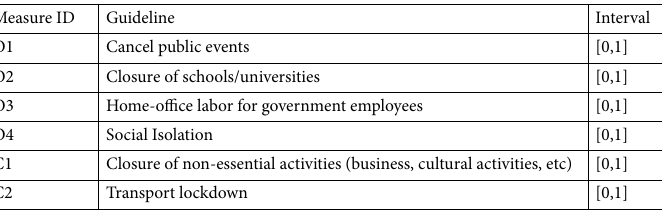
Table 1. Categories of governmental measures to mitigate the spread of COVID-19 in Bahia. Details are described in the work of Jorge et al. 7